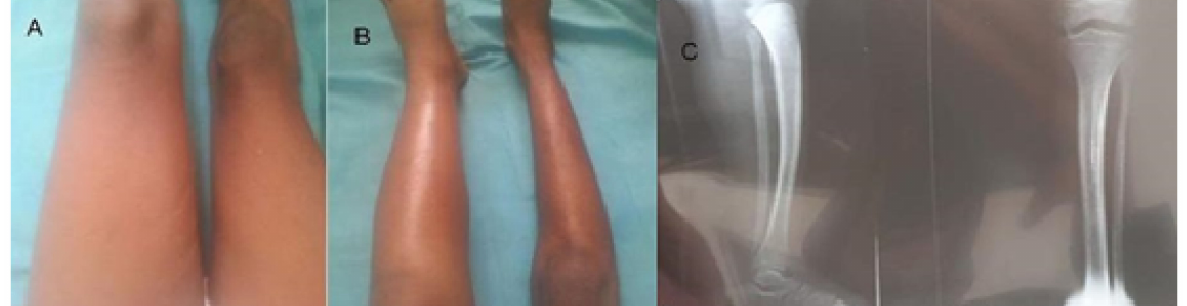
Figure 1. ( A ) Patient on initial presentation, left thigh swelling (mid-thigh circumference 31 cm). Right thigh (mid-thigh circumference 25 cm); ( B ) Patient on initial presentation, left leg swelling (mid-leg circumference 26 cm). right mid-leg circumference 20.5 cm and ( C ) Patient on initial presentation, left and right leg X-ray.